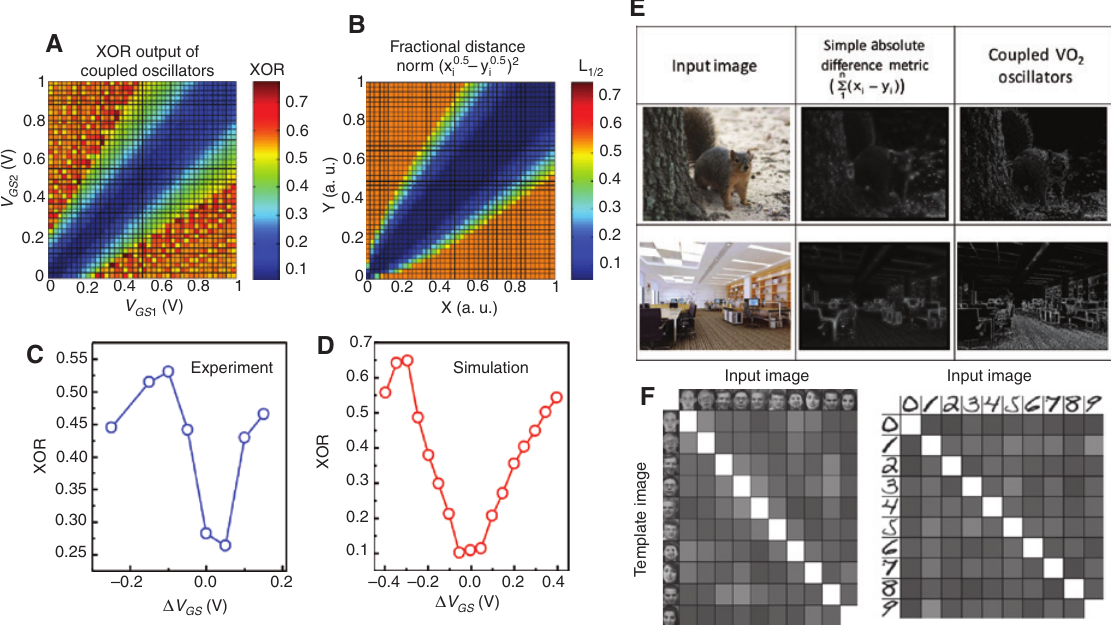
Figure 6: (A, B) XOR output of pairwise coupled oscillators shows close similarity with fractional norm measure between two inputs. (C, D) Experimental results and simulations reveal the capability of coupled oscillator phases to encode a measure of difference between two inputs ( Δ V ). (E) Saliency detection of images using coupled oscillator systems and a digital implementation, (F) a pairwise XOR measure is GS extended to illustrate pattern matching between an input and a template. A lighter color corresponds to a better